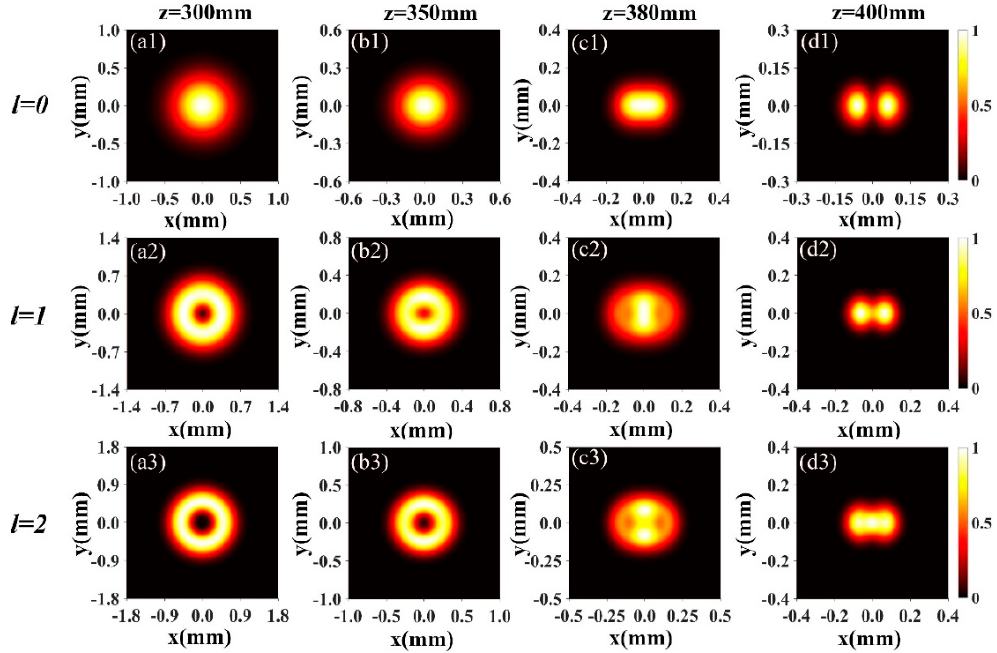
Figure 2. Normalized intensity of a focused HGCSMLG 0l beam at different distances with m = 0, n = 1 and increasing values of the topological charge (TC).